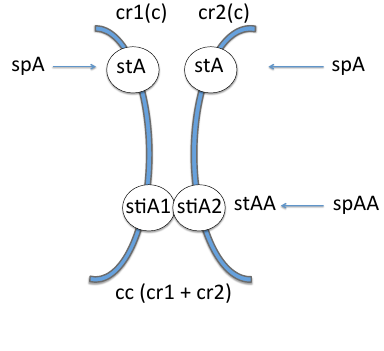
Figure 15: Reaction: spA(cr1) + spA(cr2) –>